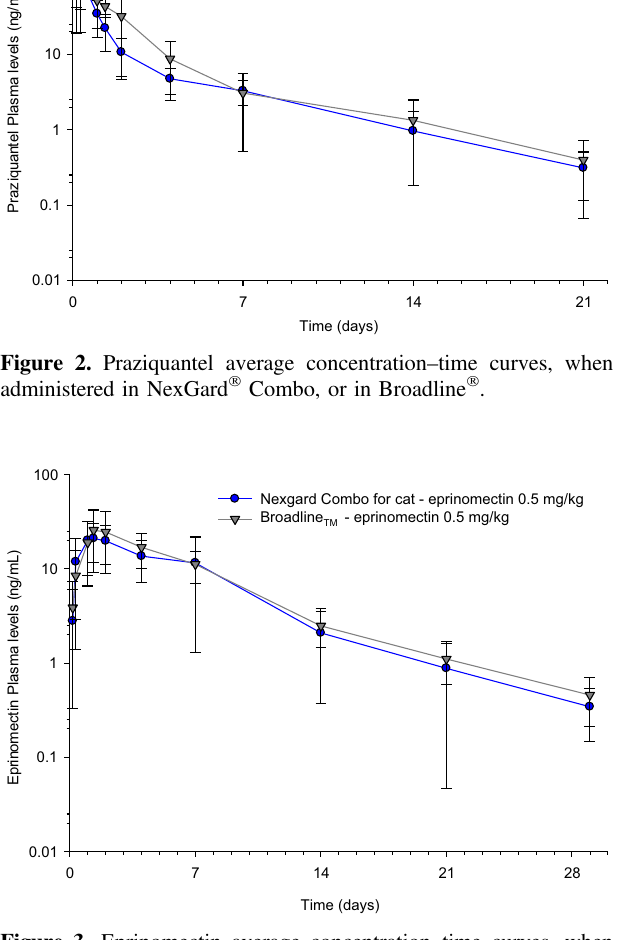
Figure 3. Eprinomectin average concentration – time curves, when administered in NexGard (cid:1) Combo, or in Broadline (cid:1)